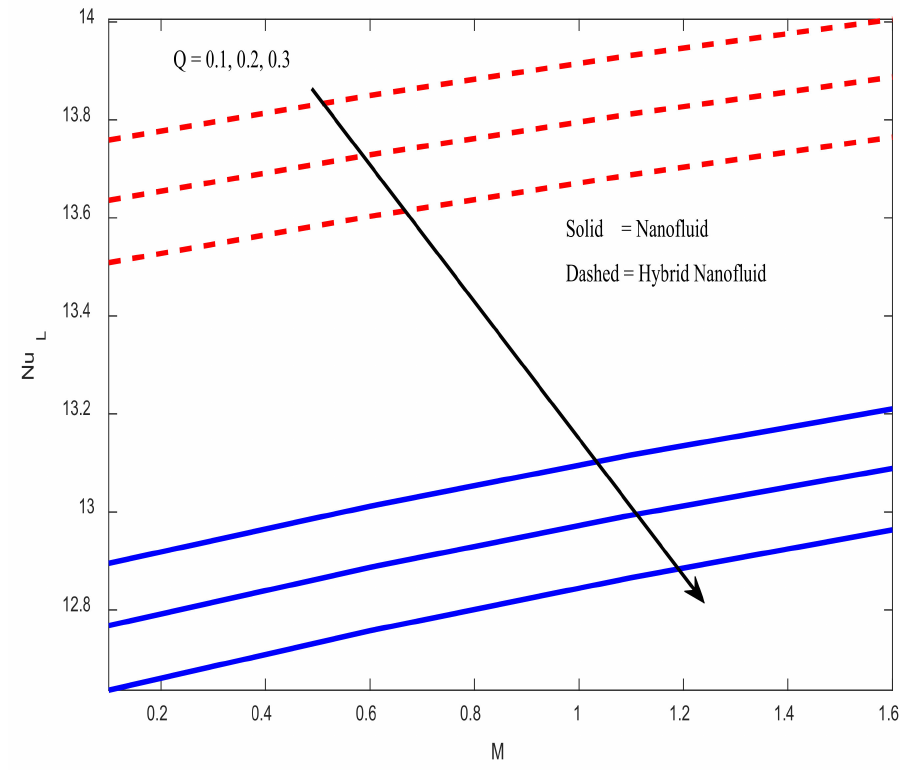
Figure 14. Influence of Q on heat transfer rate near the lower wall.